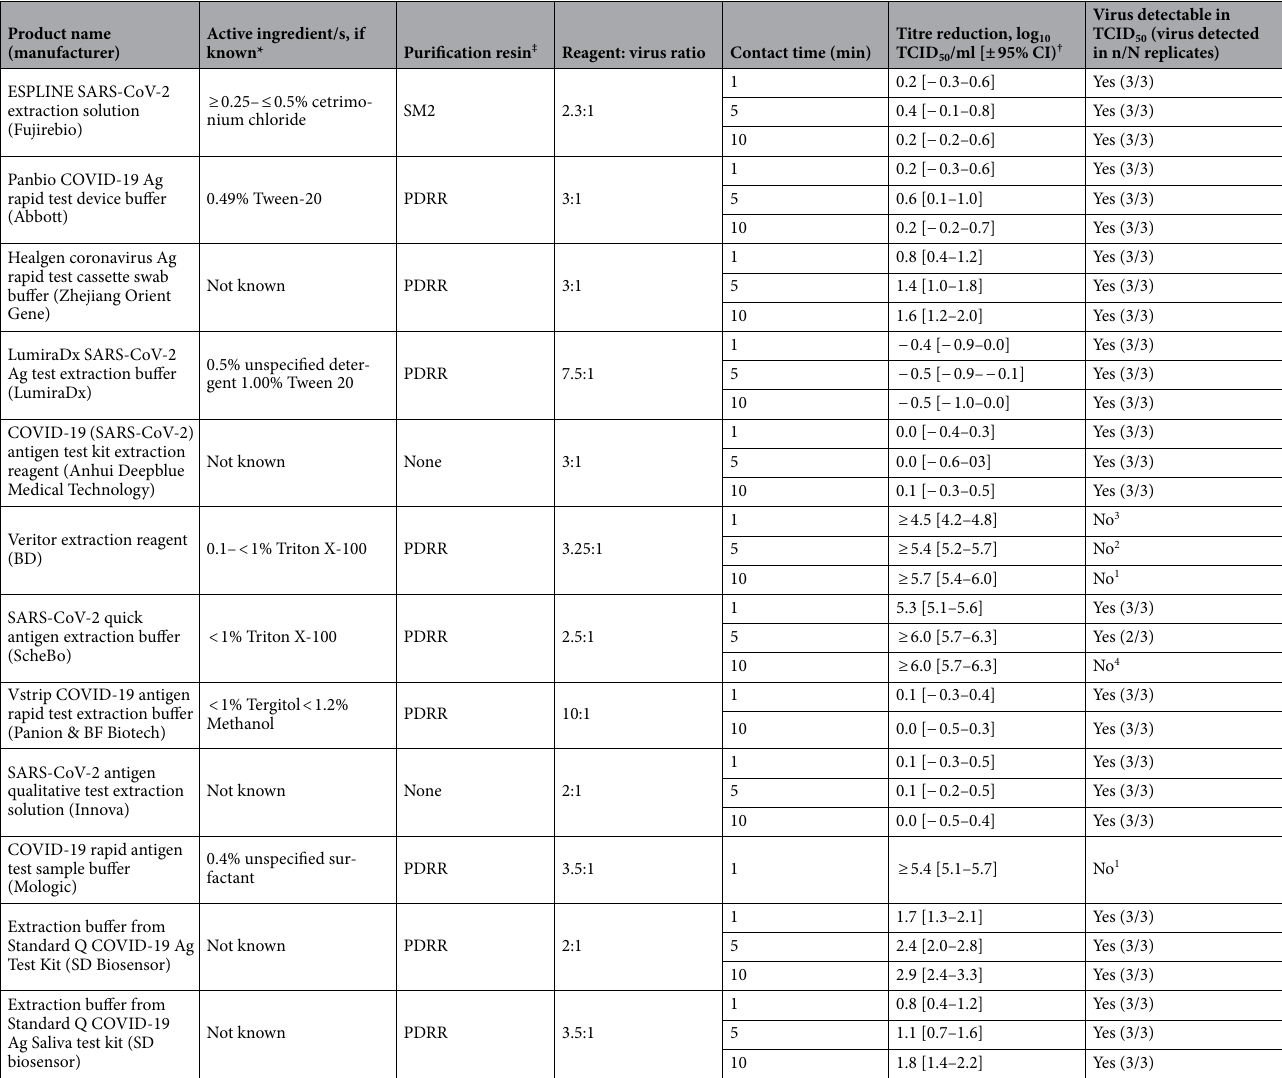
Table 2. SARS-CoV-2 inactivation by rapid antigen test buffers. *As indicated on product safety data sheets or other product literature. † Values are given as ≥ when at least one replicate was below the limit of